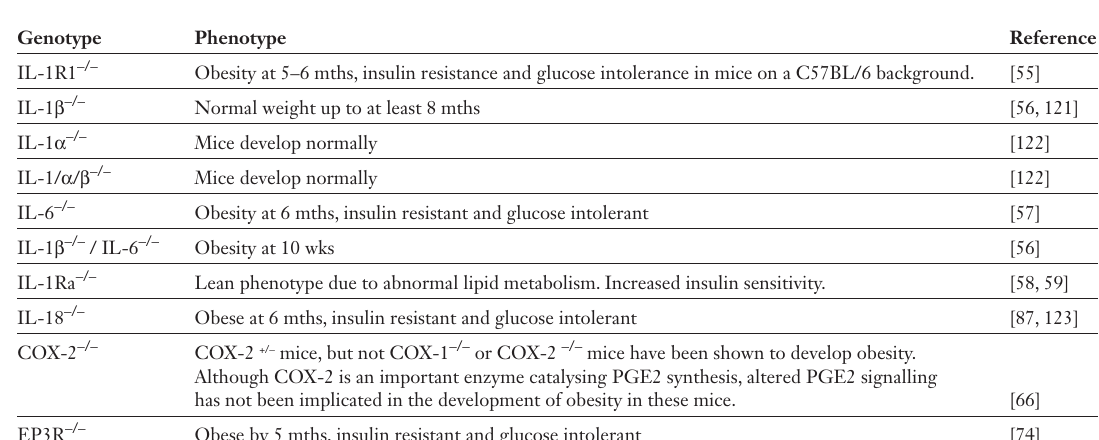
Cytokine, inflamma- tory signalling deficient mice (on a C57Bl/6 genetic background) which exhibit alterations in body weight homeostasis on normal